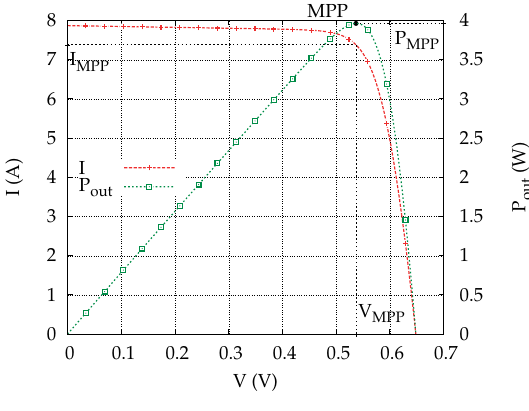
Figure 11. Single cell